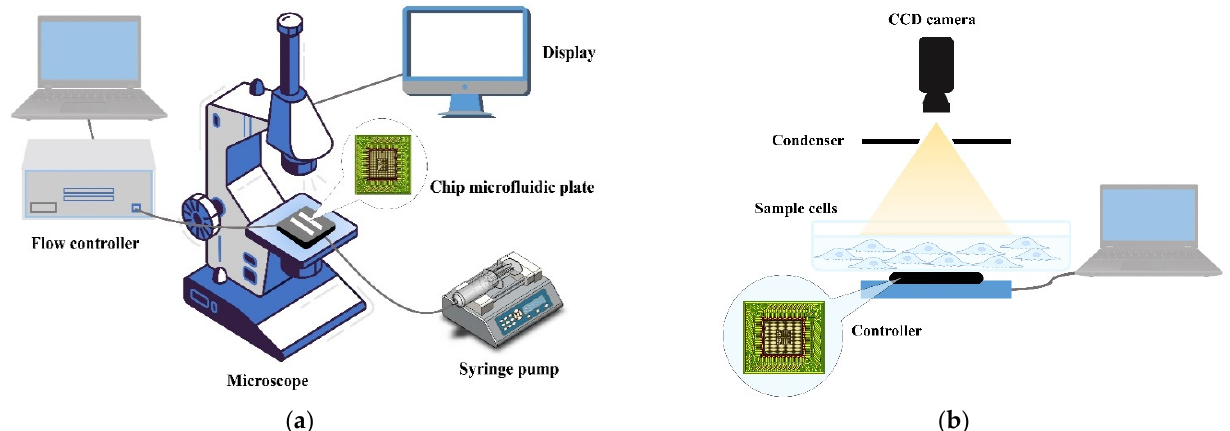
Figure 3. Optical measuring methods: ( a ) schematic of flow imaging microscopy (FIM) techniques; ( b ) digital holographic microscopy.